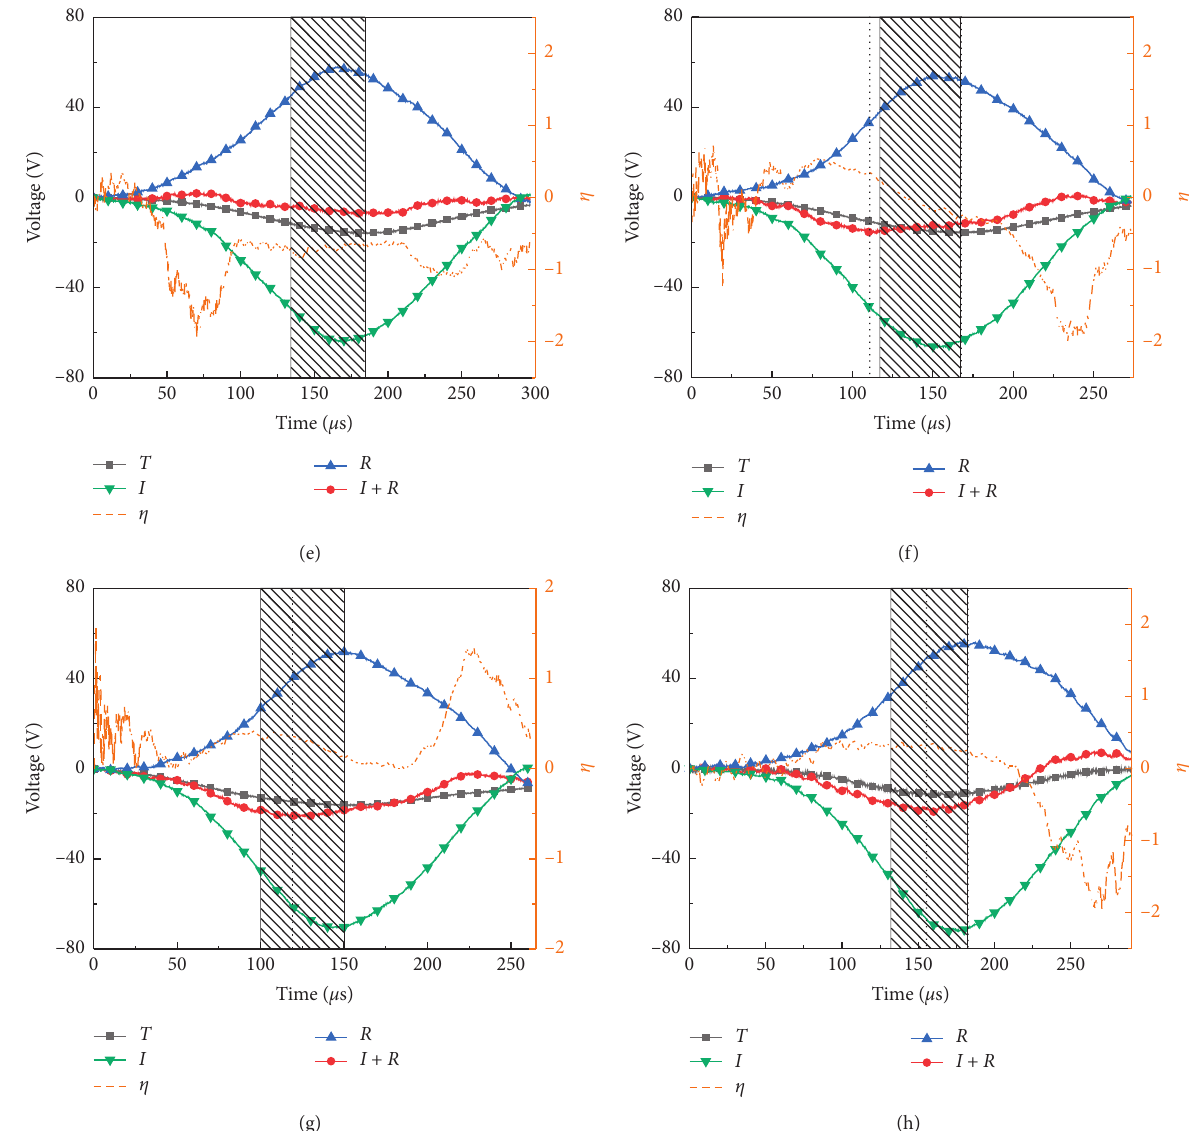
Figure 5: Stress equilibrium of samples with different L / D ratios. (a) L / D � 0.3. (b) L / D � 0.4. (c) L / D � 0.5. (d) L / D � 0.6. (e) L / D � 0.7. (f) L / D � 0.8. (g) L / D � 0.9. (h) L / D �